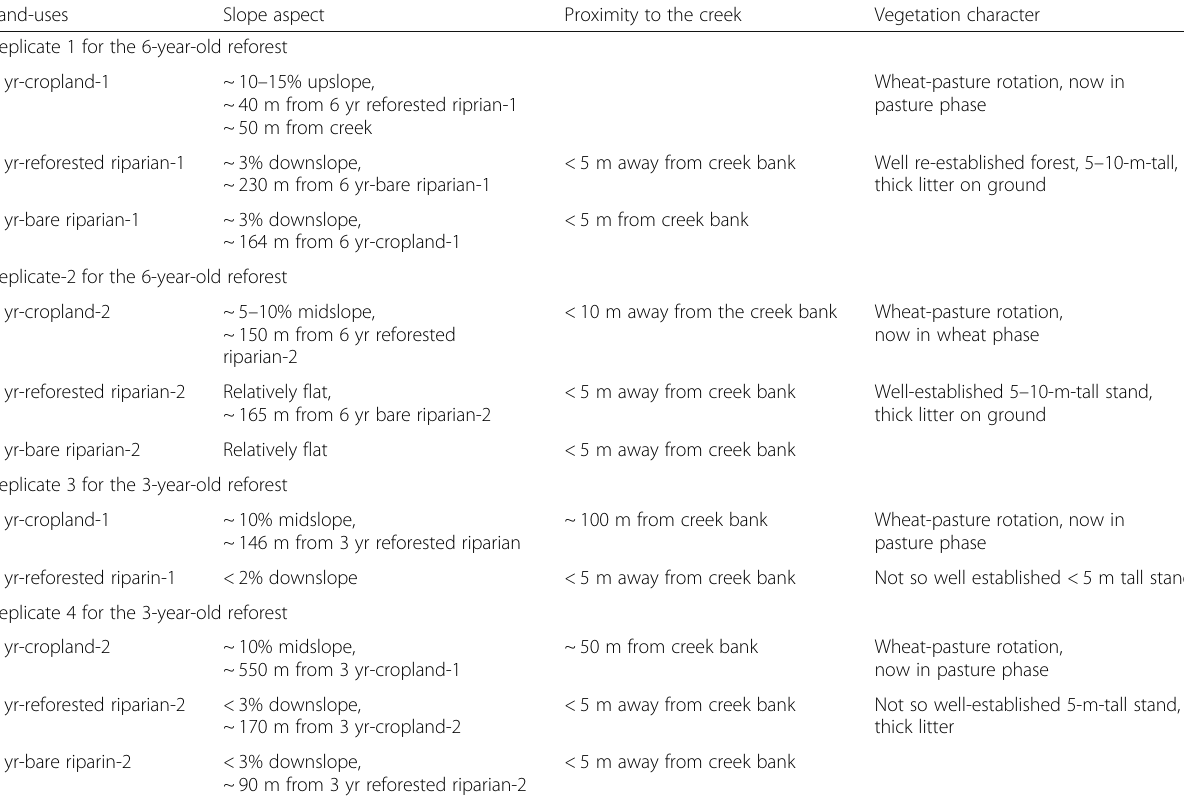
Table 1 Land-use practices at four locations in the farm and their physical characteristics. During the experimental design stage, two out of the four transects were considered as replicates for the 3-year-old reforested riparian (RR) and the corresponding cropland (CP) and bare riparian (BR) land-uses for this time-period. Similarly, the other two transects for the 6-year-old RR, and the corresponding CP, and BR